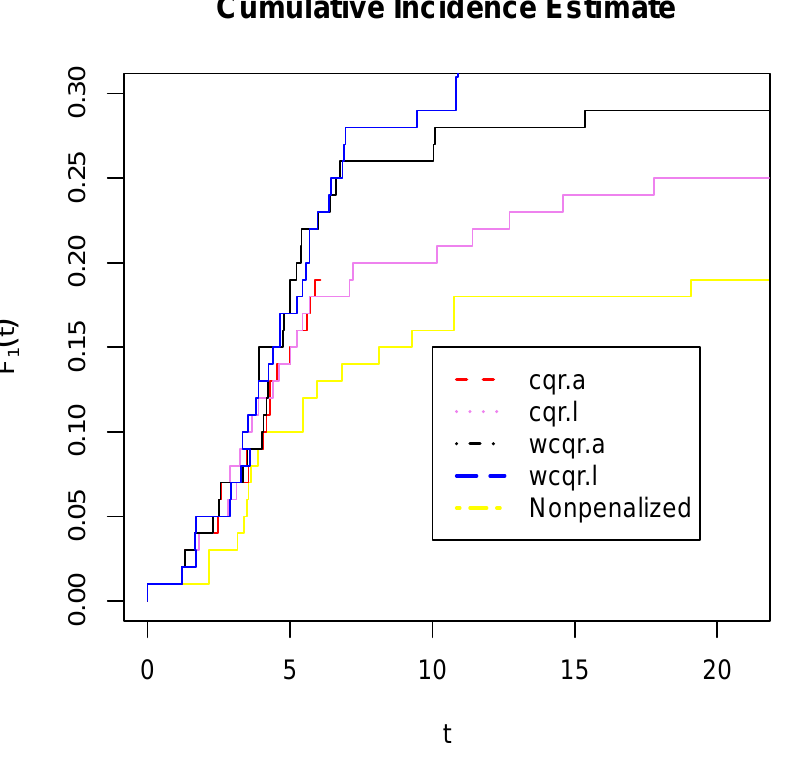
Figure 6. Estimation of F 1 . The Y axis reports the estimated values of F 1 ( t ) at different t . Various colors of lines represent eight